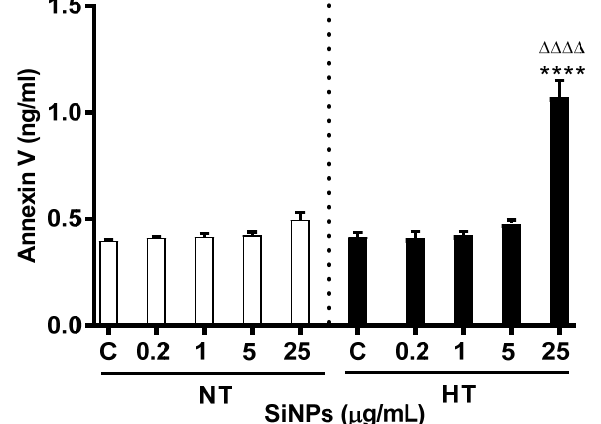
Figure 9. Effect of various concentrations ( µ g/mL) of silica nanoparticles (SiNPs) on the concentration of bound Annexin V in the incubation medium of erythrocytes of normotensive (NT) and hypertensive (HT) rats. Data are mean ± SEM ( n = 8 in each group). Statistical analysis by one-way analysis of variance (ANOVA) followed by the Holm–Sidak multiple comparisons test. **** p < 0.0001 vs. respective control and ∆∆∆∆ p < 0.0001 vs. respective concentration in NT group.